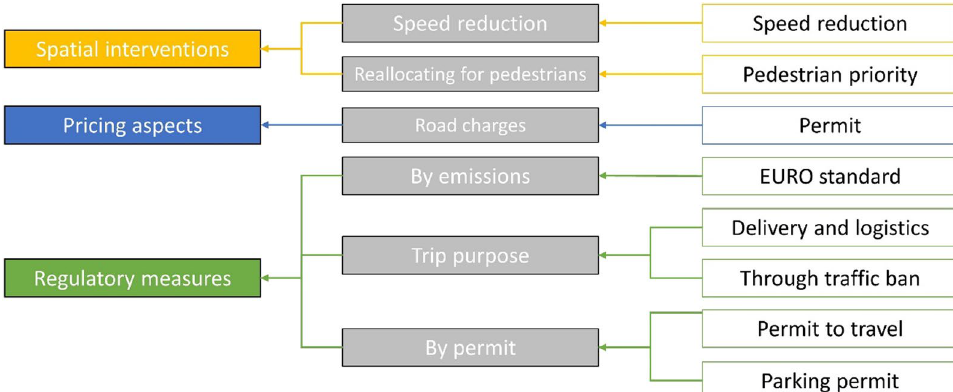
Fig. 14 Schematic representation of the UVAR taxonomy applied for the case study of Bologna (implementation of a limited traffic